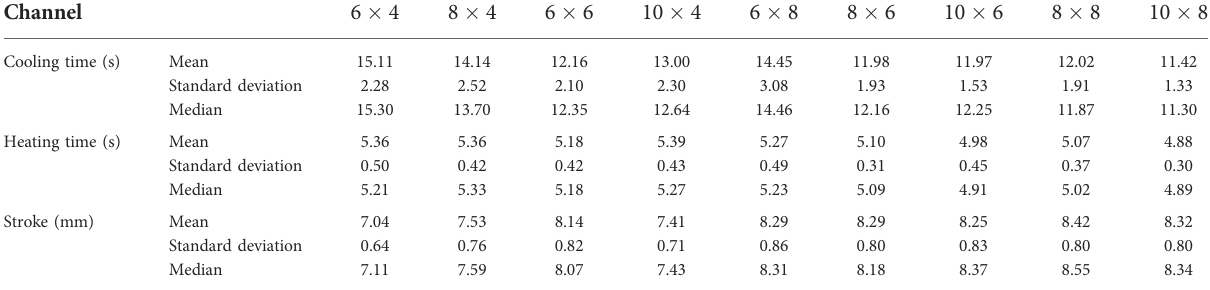
TABLE 2 Descriptive statistics for the parameters that were assessed to compare TCA performance in channels with different dimensions.